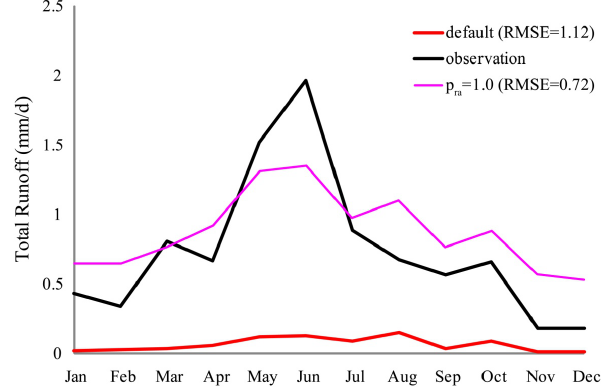
Figure 12. Simulated runoff using the posterior estimates of parameters at the MOPEX basin. 829 Fig. 12. Simulated runoff using the posterior estimates of parame- ters at the MOPEX